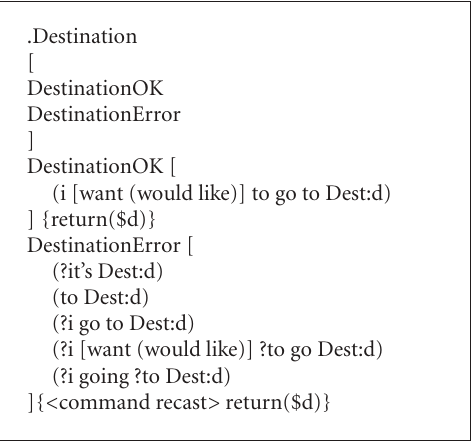
Figure 2: “At the station” recognition grammar